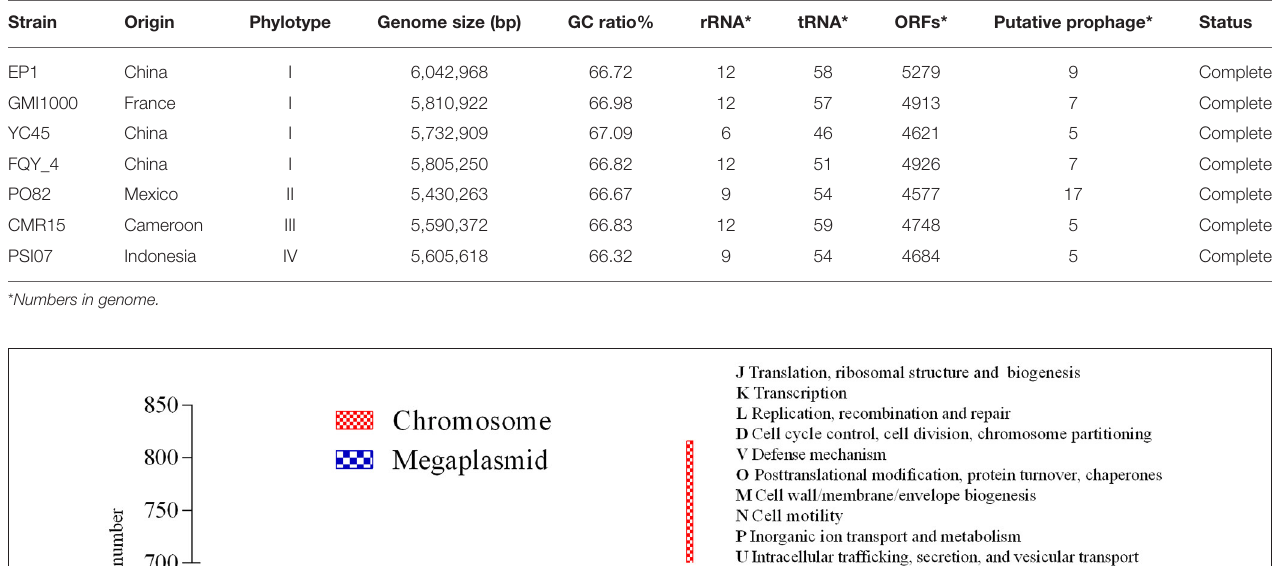
TABLE 1 | General genomic feature of different Ralstonia solanacearum strains.